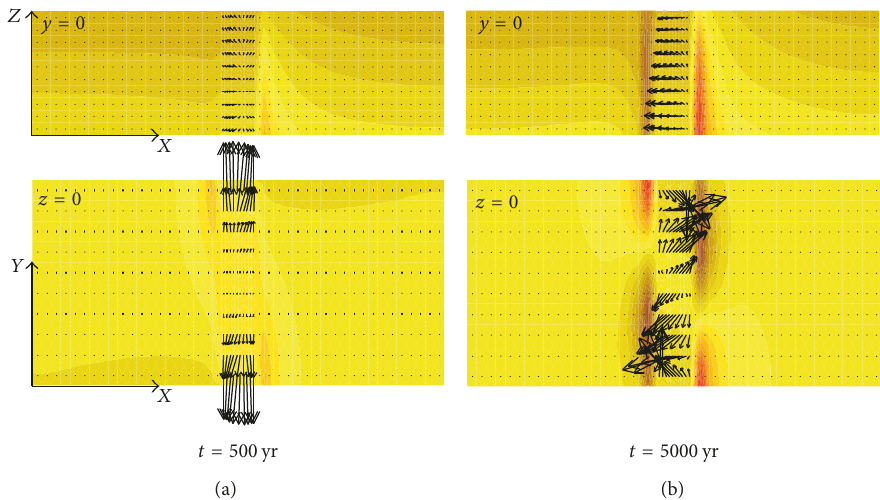
Figure 7: The flow direction in two cross sections ( 𝑌 = 0 and 𝑍 = 0 ) of Model II at 𝑡 = 500 yr and 5000 yr.